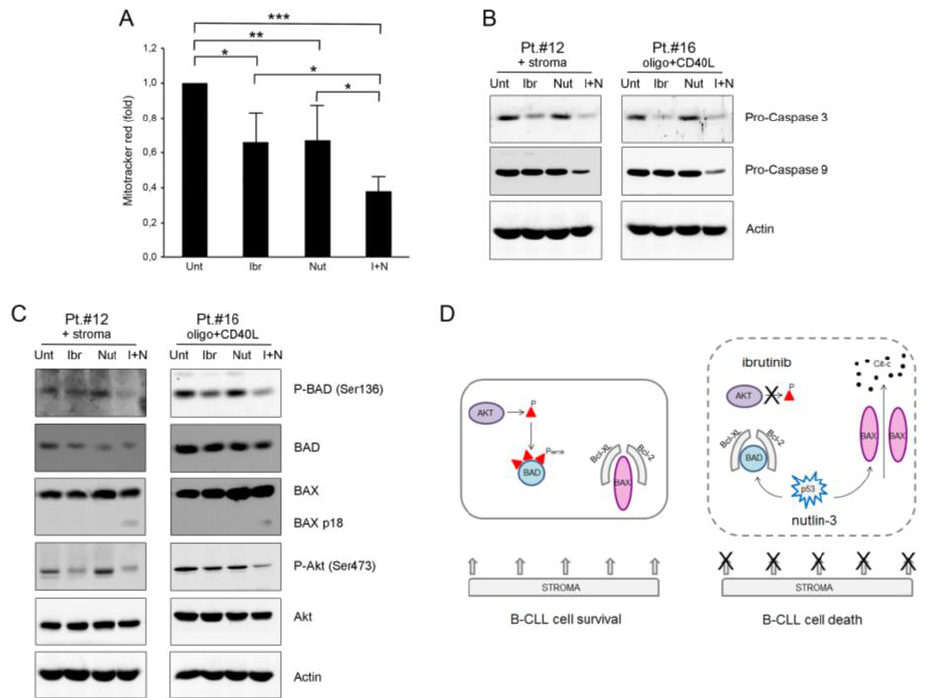
Figure 4. Ibrutinib plus nutlin-3 combination mediates mitochondria-dependent apoptosis through inhibition of phospho-BAD. Patients’ derived B-CLL cells were grown in vitro with stroma or with CpG-ODN and CD40L and exposed to ibrutinib (10 µ M), nutlin-3 (10 µ M), ibrutinib+nutlin-3 (10 µ M) for 24 h or left untreated as control. In ( A ), mitochondrial activity, evaluated using MitoTracker ® Red staining on B-CLL cells stimulated with CpG-ODN and CD40L, was analyzed by flow cytometry and expressed as fold of modulation with respect to the MFI value of the untreated B-CLL cultures set at 1. Results are reported as mean ± SD of five independent experiments. Statistical analysis was performed by ANOVA followed by Bonferroni post-hoc test. Asterisks indicate: *, p < 0.05; **, p < 0.01; ***, p < 0.001. In ( B ), Western blotting analyses of pro-caspase 9 and pro-caspase 3 protein levels are shown. In C, Western blotting analyses of BAD phosphorylation in ser136, total BAD, BAX, Akt phosphorylation in ser473 and total Akt protein levels are shown. In ( B , C ), results are shown for representative B-CLL patients and β -actin levels are shown as loading control. In ( D ), schematic representation of early molecular events that drive the mitochondria-dependent apoptosis following the combination treatment ibrutinib plus